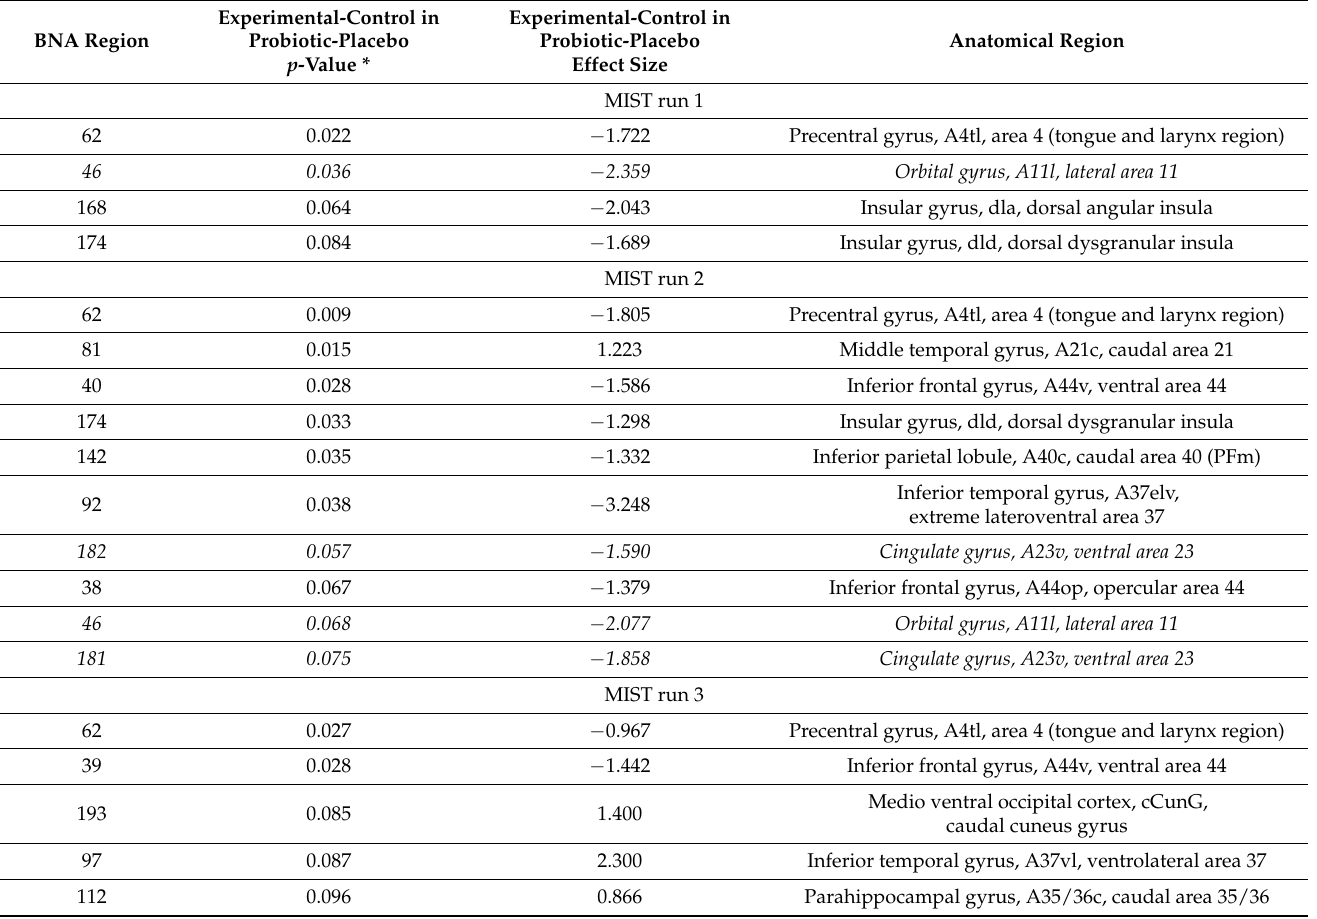
Table 1. BNA regions that were found to be associated with changes in brain activity ( p < 0.1) between both interventions when comparing the experimental and control condition before multiplicity correction during the MIST paradigm. Several of these BNA regions were among the predefined ROIs